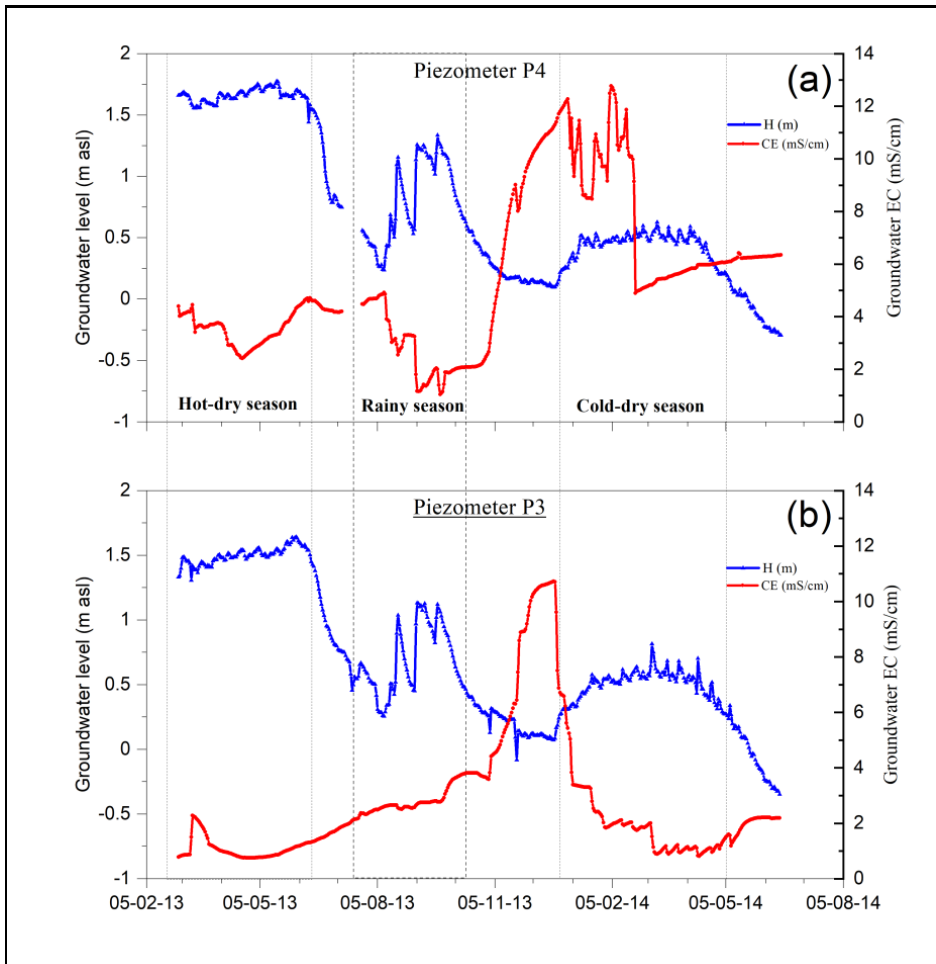
Figure 7. Comparative evolution of the piezometric level and the EC of the shallow groundwater at the P4 ( a ) and P3 ( b ) piezometers.